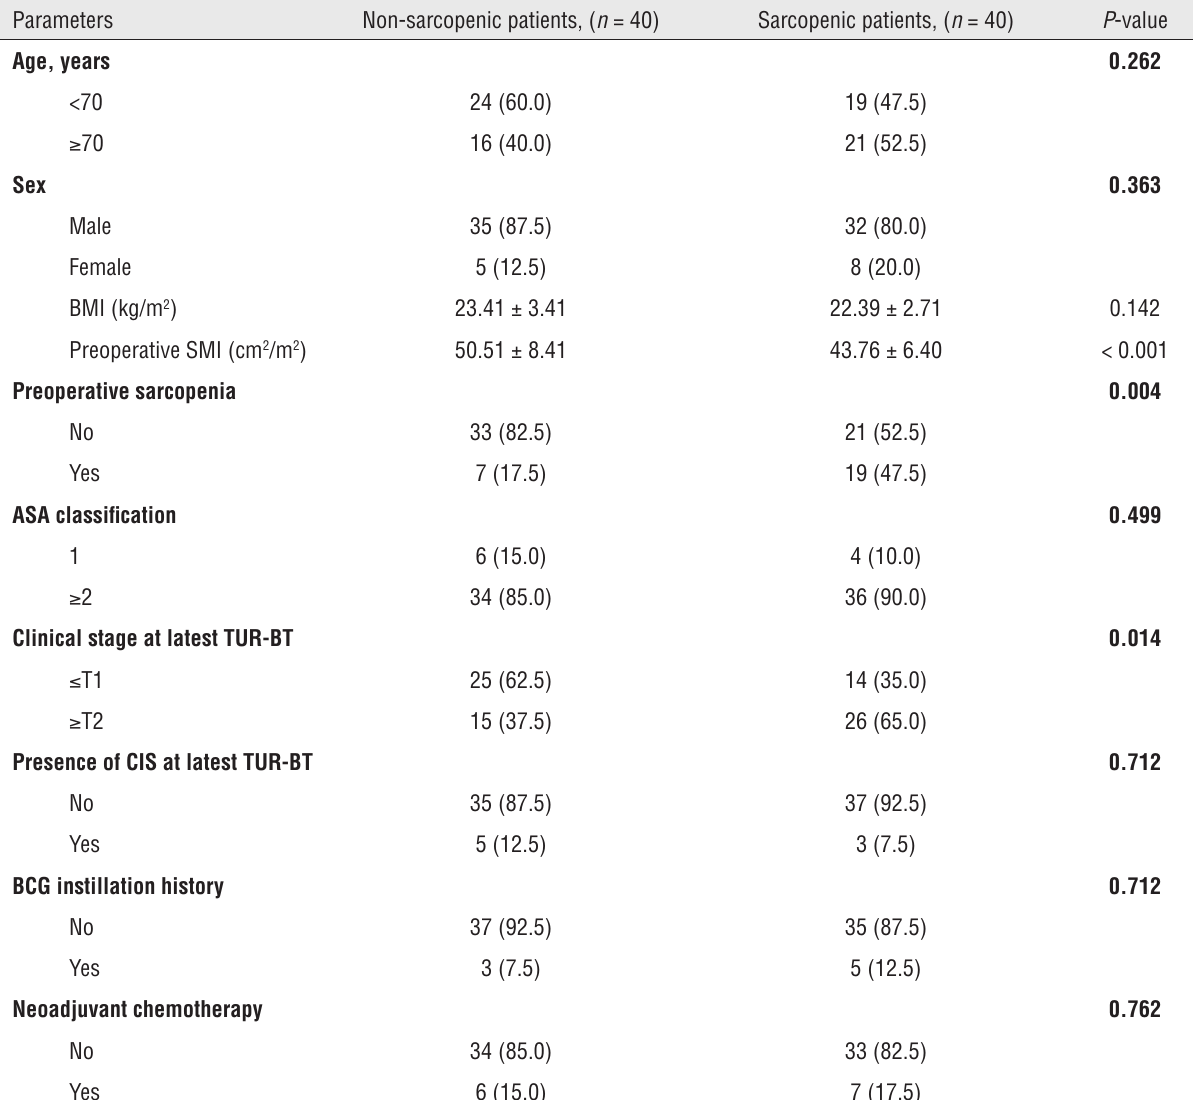
Table 1 - Patient demographics and preoperative characteristics according to skeletal muscle index one year after radical